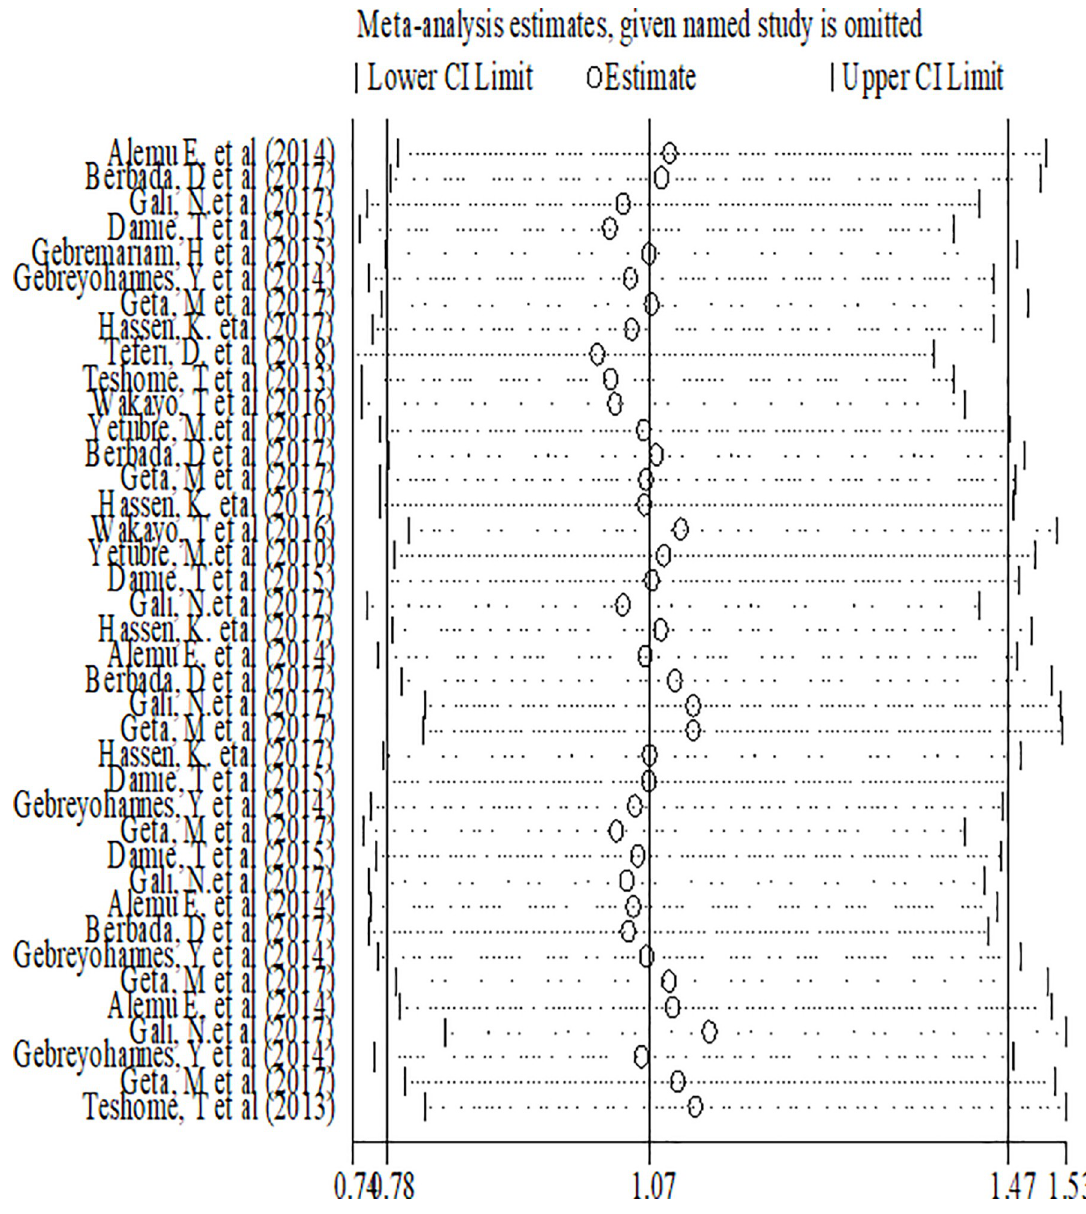
Fig 16. Sensitivity analysis of factors associated with overweight/obesity in